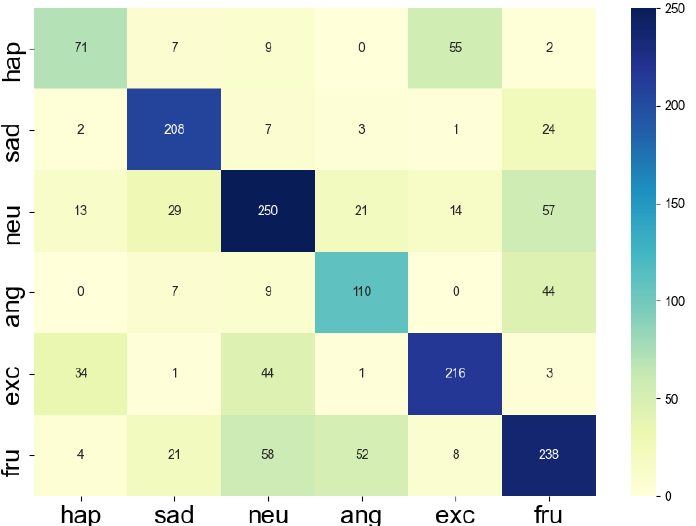
Figure 10. The heatmap of the confusion matrix on IEMOCAP dataset; hap = happy, neu = neutral, ang = angry, exc = excited, fru = frustrated. X-coordinate: model’s prediction and y-coordinate: the ground